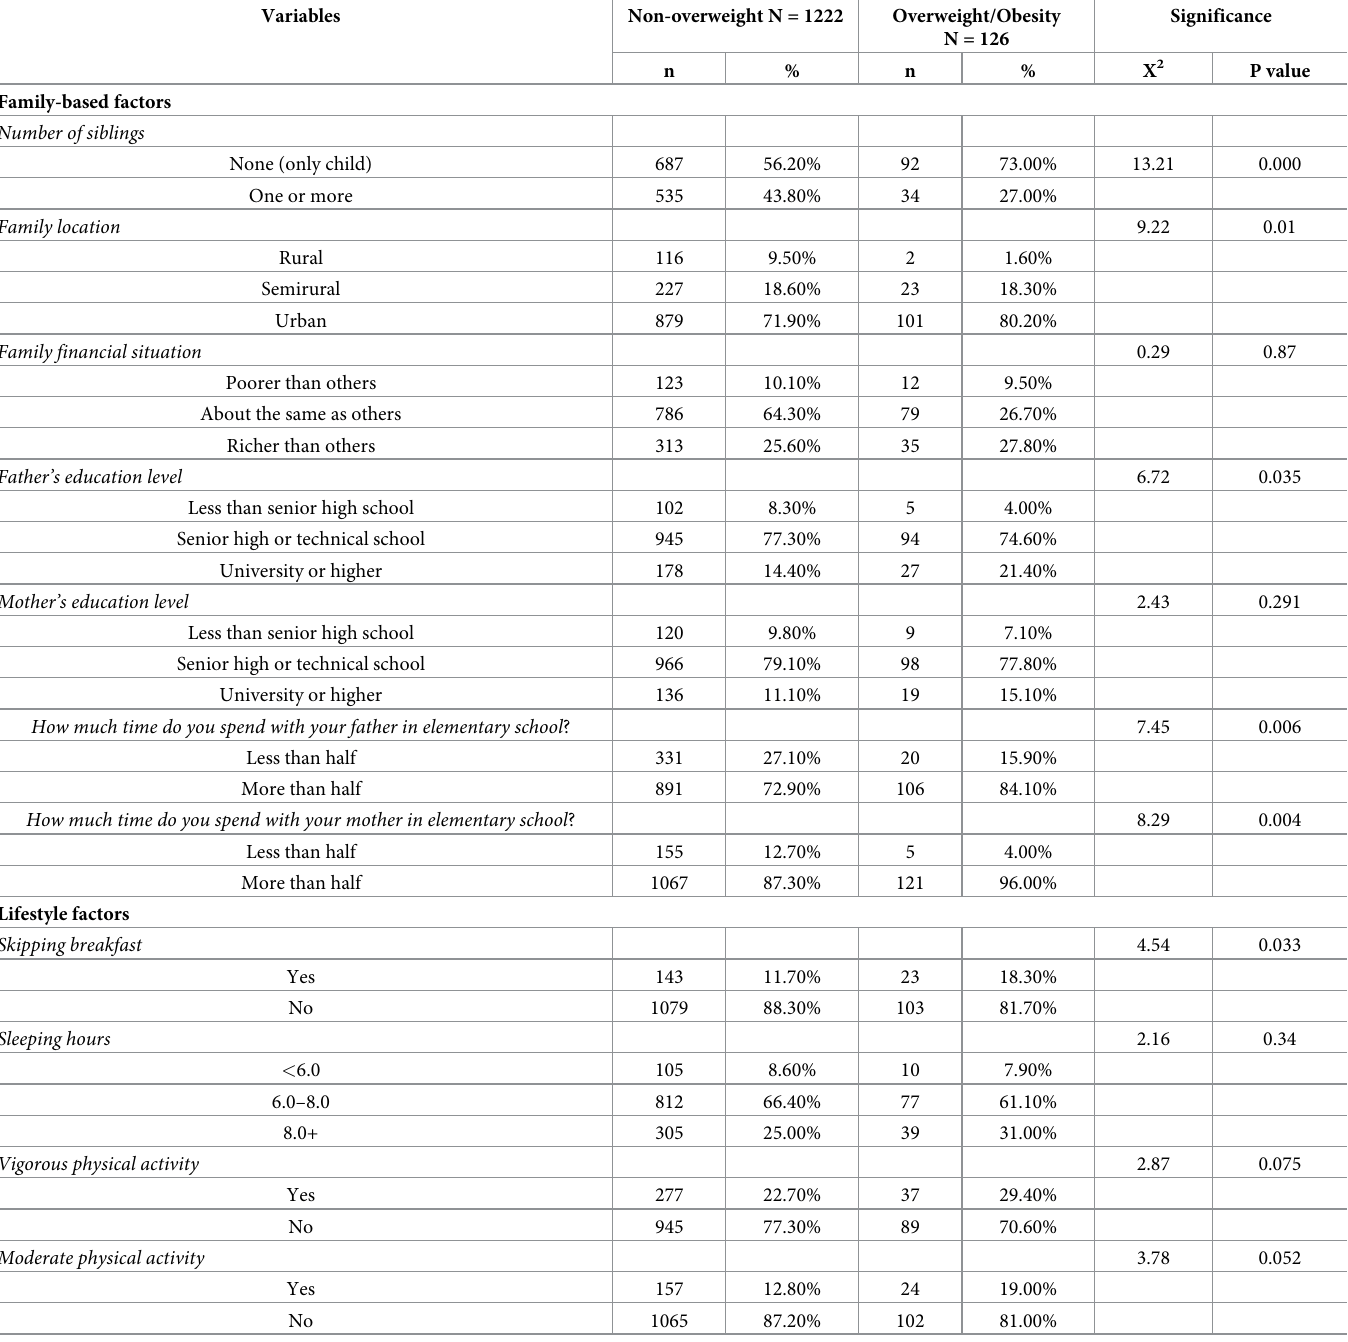
Table 1. Characteristics of the non-overweight and overweight/obesity